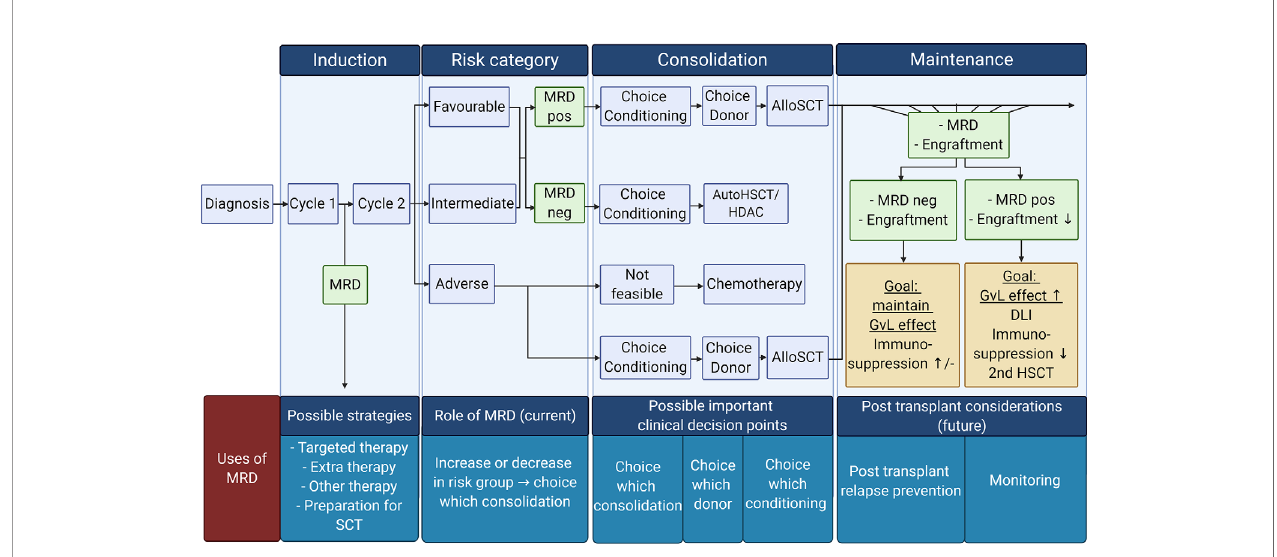
FIGURE 2 | Overview of possible MRD tailored therapy in different AML treatment phases: Current use of MRD tailored therapy focuses on the choice of consolidation therapy (post-remission therapy). However, other uses of MRD are also emerging. Future possibilities for MRD usage in the clinic can be the choice in conditioning treatment, donor in the consolidation phase, and prevention of relapse strategies in the maintenance phase. Pos, positive; Neg, negative; AutoSCT, autologous hematopoietic stem cell transplantation; HDAC, high doses cytarabine; AlloSCT, allogeneic hematopoietic stem cell transplantation; GvL, Graft versus Leukemia; DLI, donor lymphocytes infusion. Created with BioRender.com.